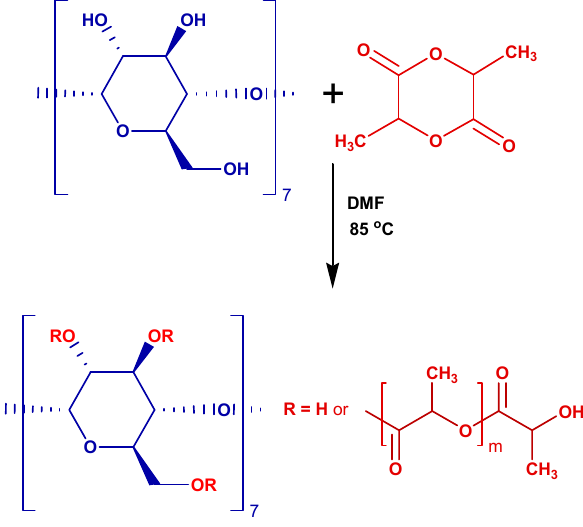
Scheme 1. Ring opening of L -lactide (LA) in the presence of cyclodextrins